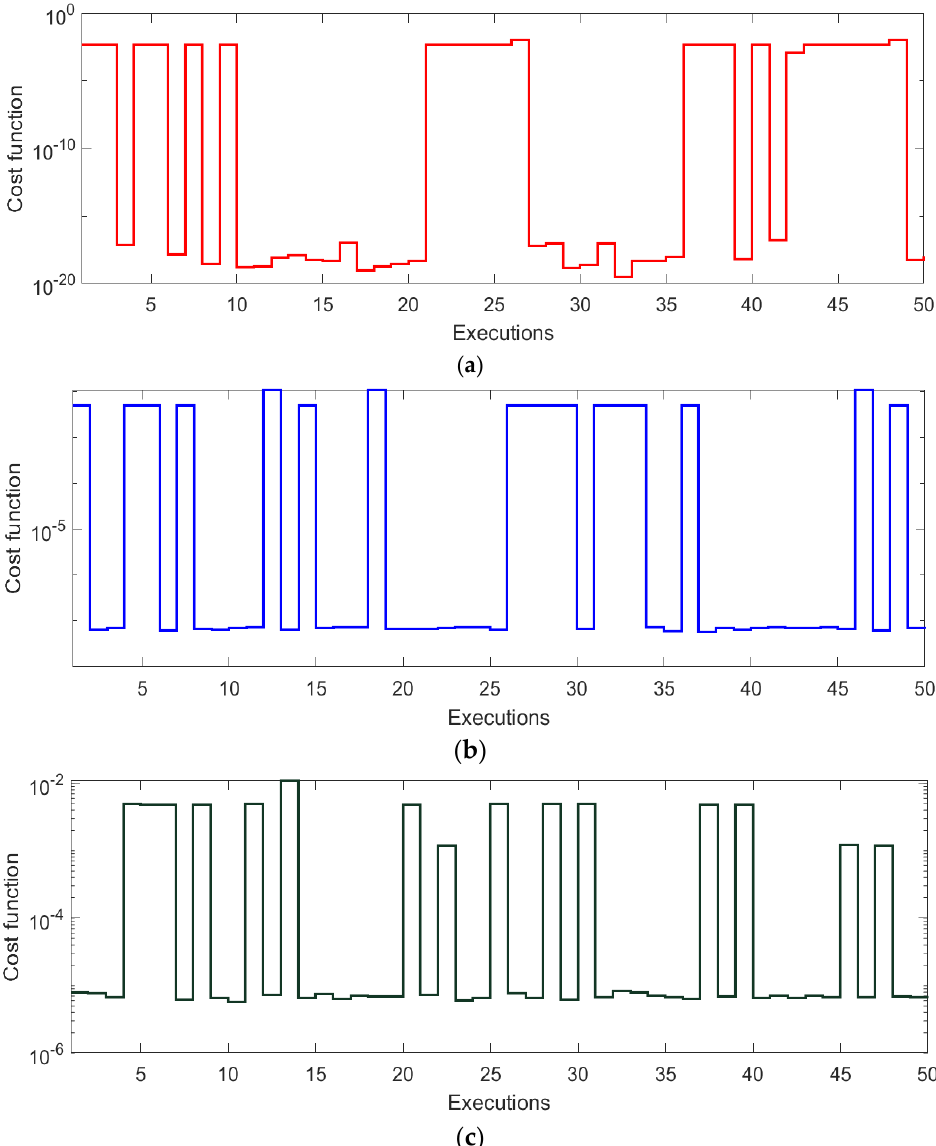
Figure 11. Monte Carlo simulation results for 1.0 λ ( a ) 200 dB ( b ) 70 dB ( c ) 50 dB. Analyses in terms of statistical indices of the minimum (Mini) value of cost function, the mean and standard deviation (STDD) were conducted and the results are reported in Table 4. The Mini values indicated that the FOPSO was accurate and convergent for all λ